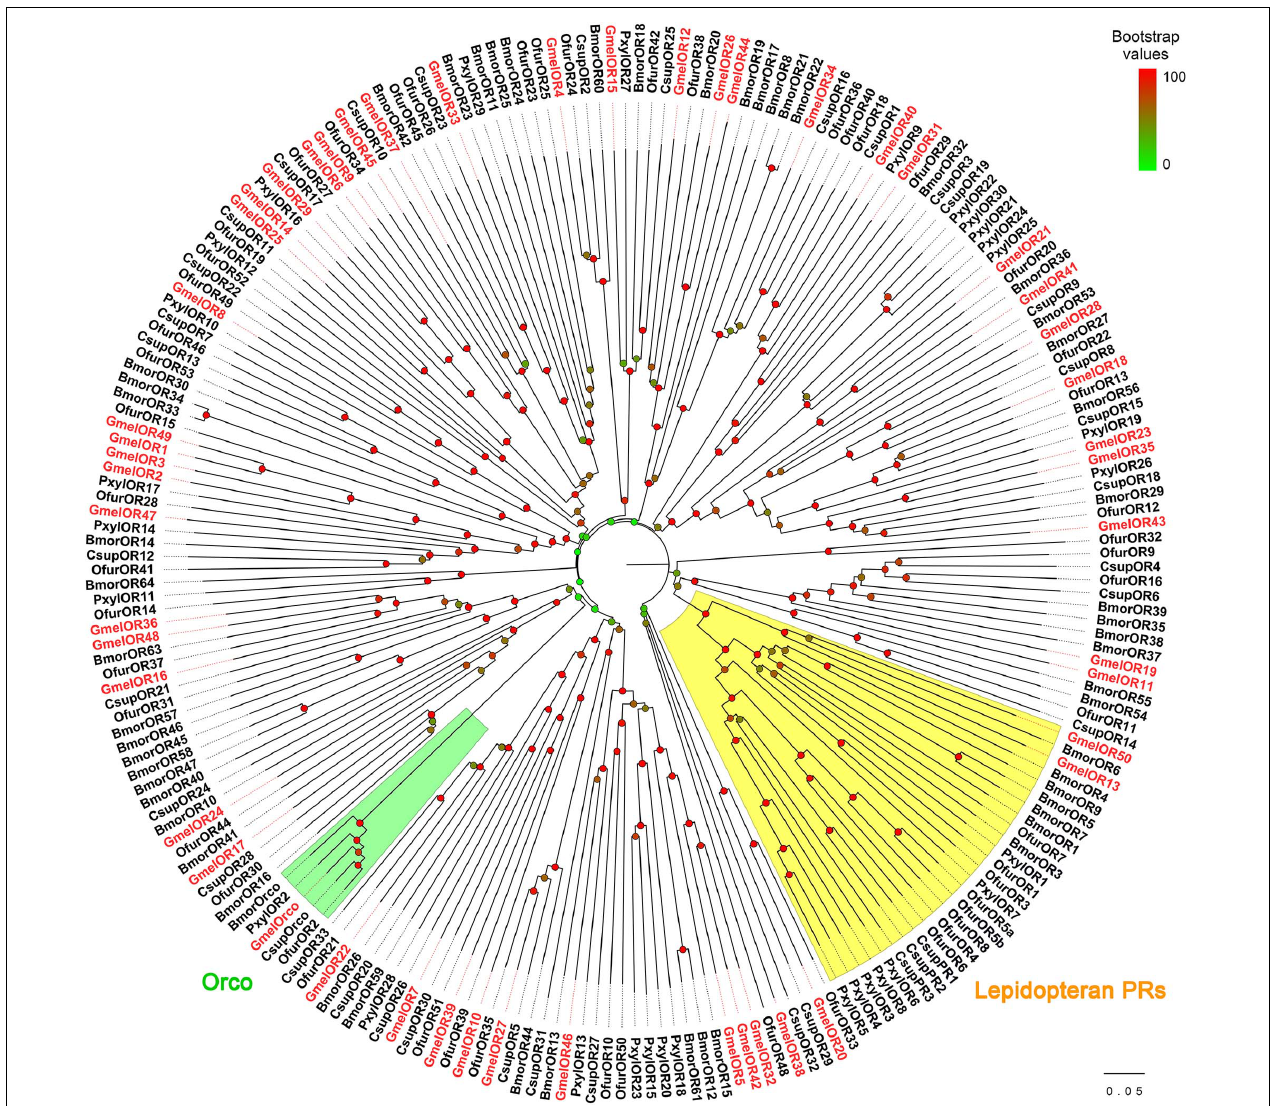
FIGURE 6 | Phylogenetic relationships of lepidopteran ORs. Gmel: Galleria mellonella ; Bmor: Bombyx mori ; Ofur: Ostrinia furnacalis ; Csup: Chilo suppressalis ; Pxyl: Plutella xylostella . Bootstrap values are indicated by colors from green (0) to red (100). The G. mellonella OR s are highlighted in red. GmelOR30 was not used for the analysis due to its short length. GenBank accession numbers of ORs used are listed in Supplementary Table 1